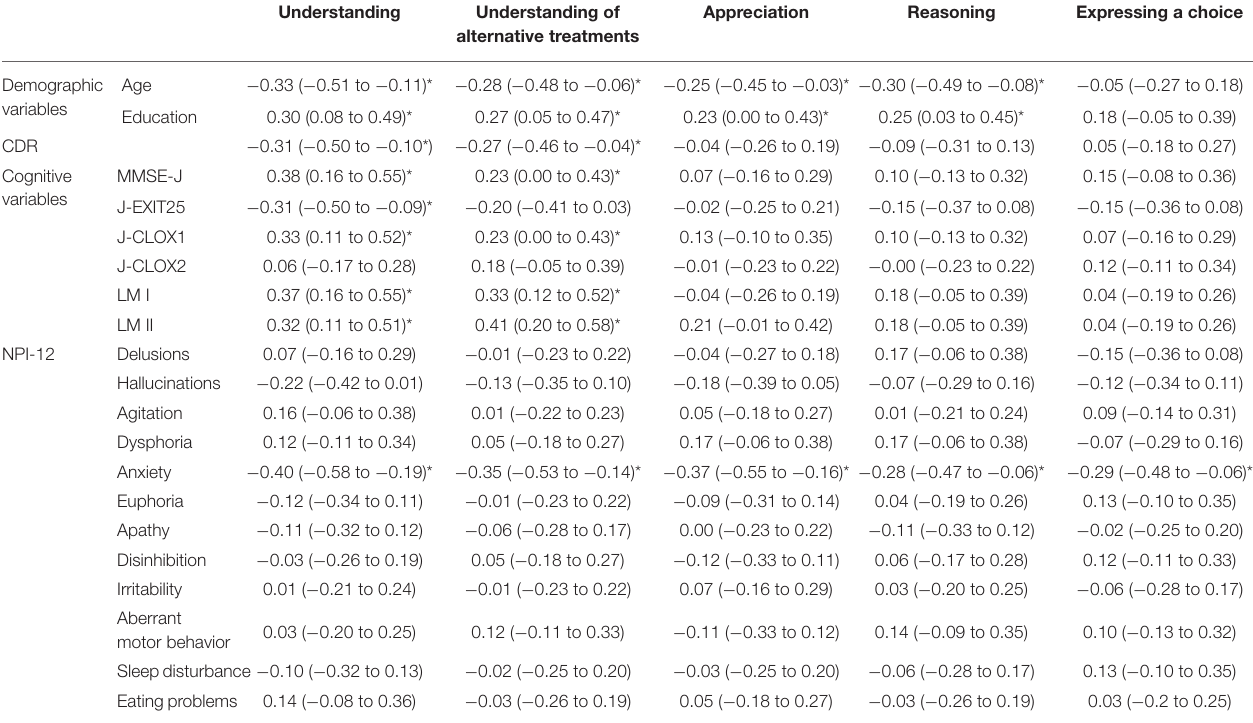
TABLE 4 | Spearman correlations between the MacCAT-T and demographic and cognitive variables and NPI